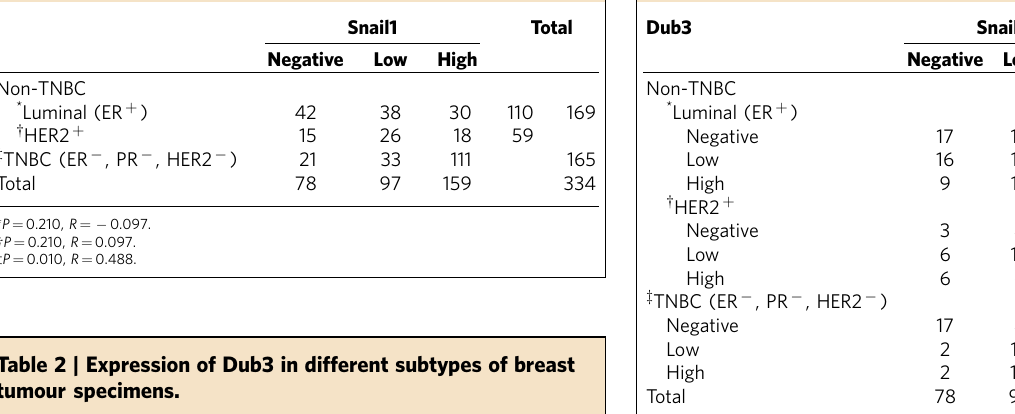
Table 1 | Expression of Snail1 in different subtypes of breast tumour specimens.